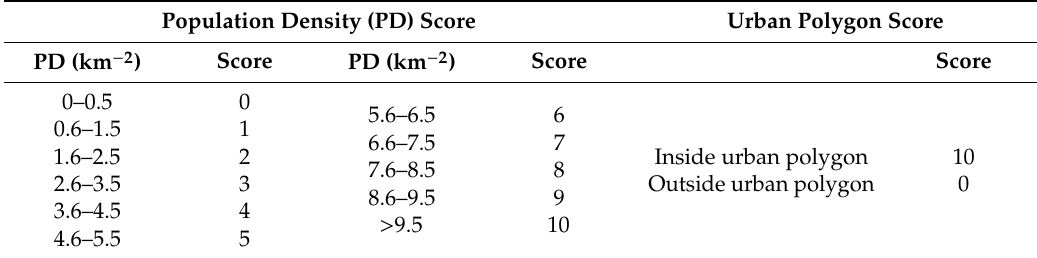
Table 2. Scores of population density and urban polygon in human influence index (HII) (based on [45]). Population Density (PD)